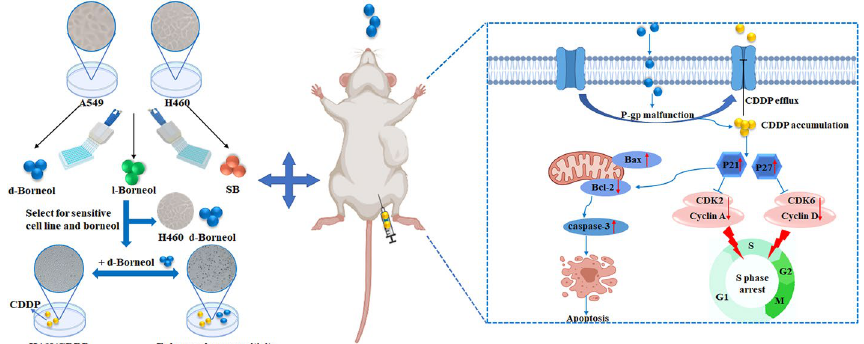
Fig. 8 Schematic diagram of antitumor effect in vivo and in vitro and the proposed signaling pathway induced by combination treatment with d-borneol and CDDP. d-Borneol enhanced the sensitivity of CDDP by increasing CDDP cellular accumulation via inhibiting P-gp function. On the one hand, d-borneol enhanced p21 and p27 and suppressed two complexes, i.e., CDK2–cyclin A and CDK6–cyclin D, which blocked the cell cycle in S phase. On the other hand, d-borneol enhanced the sensitivity of CDDP to H460/ CDDP cells by promoting the mitochondrially mediated intrinsic apoptosis via activating pro-apoptotic Bax, downregulating anti-apoptotic Bcl-2, and finally promoting activation of caspase-3, which leads to apoptosis. “ ” indicates activation, and “ ⟝ ” indicates ←